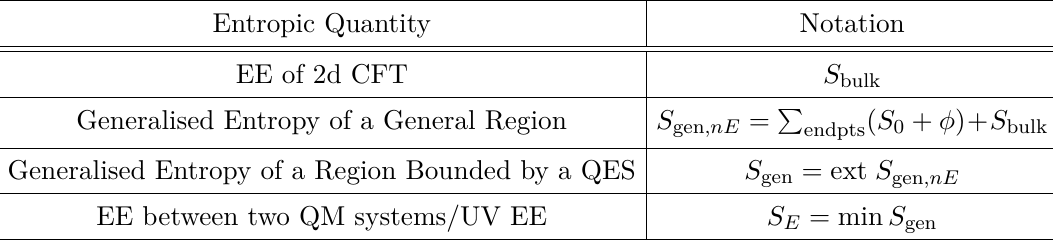
Table 1. The various entropic objects we will deal with. We will stick with this notation through- out, for